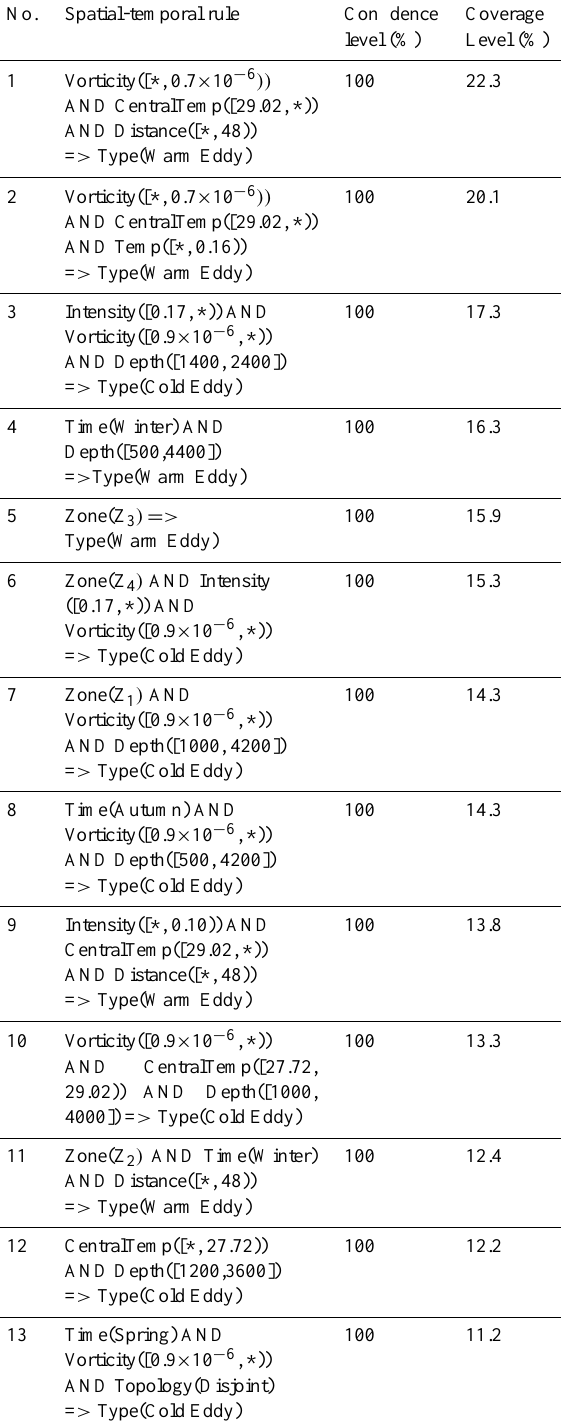
Table 7. Spatial-temporal rules extracted from typical states of two types of mesoscale